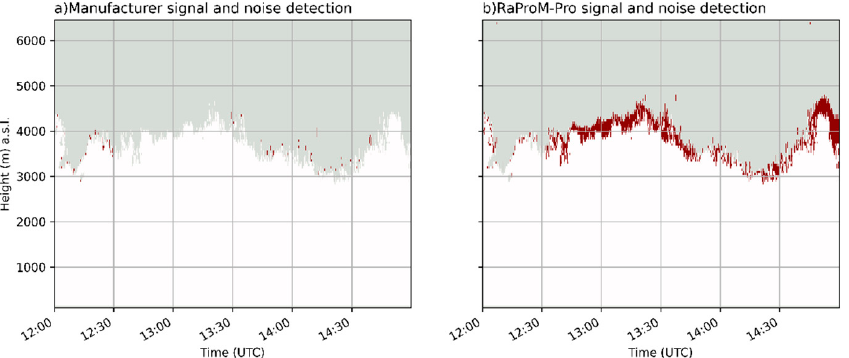
Figure A1. Signal and noise detection comparison between manufacturer and RaProm- Pro schemes: pixels with the signal detected by both methods (white), noise detected by both methods (grey), pixels detected only by the manufacturer ( a ) and RaProm- Pro ( b ) methods (red). The data were recorded from 12 to 15 UTC, 31 March 2020.